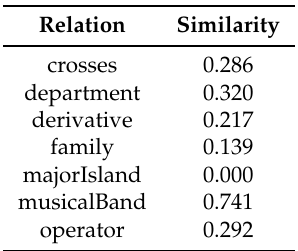
Table 9. Cross-language model similarity for different relations, averaged across the 12 most frequently extracted relations and all language